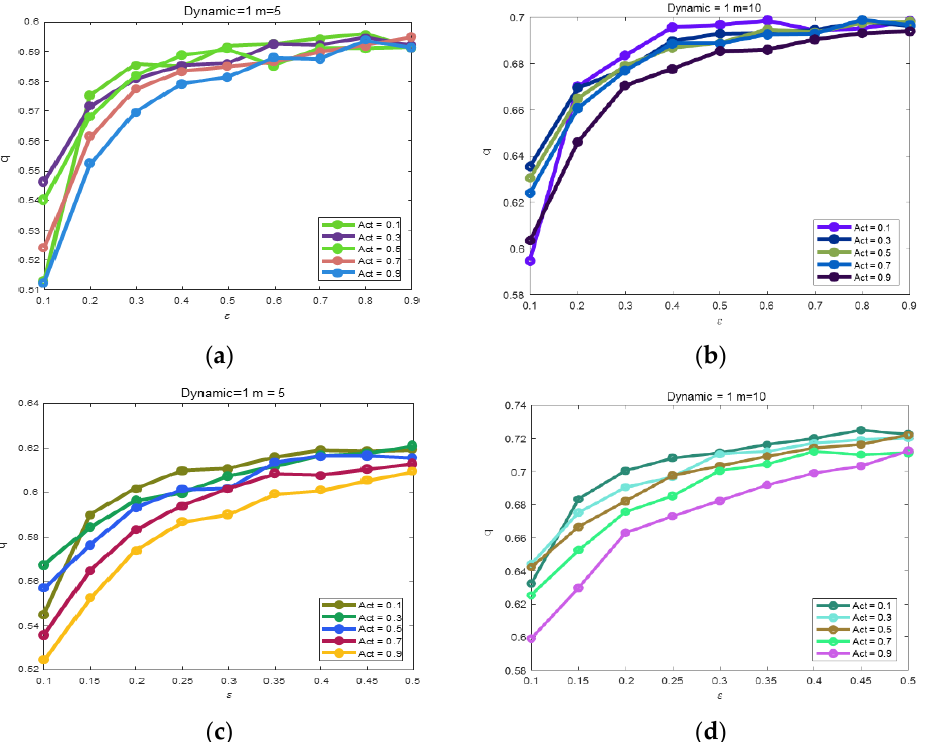
Figure 3. The effect of the number of influential individuals on product demand; ( a ) 𝜙 = 0.8, 𝑚 = 5 ( b ) 𝜙 = 0.8, 𝑚 = 10 ( c ) 𝜙 = 0.5, 𝑚 = 5 ( d ) 𝜙 = 0.5, 𝑚 = 10 .